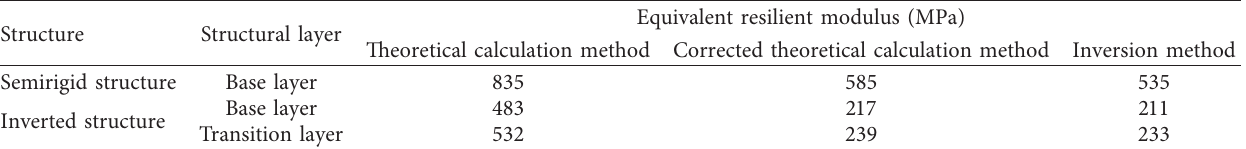
Table 8: Determination of the equivalent resilient modulus of the top surface of the structural